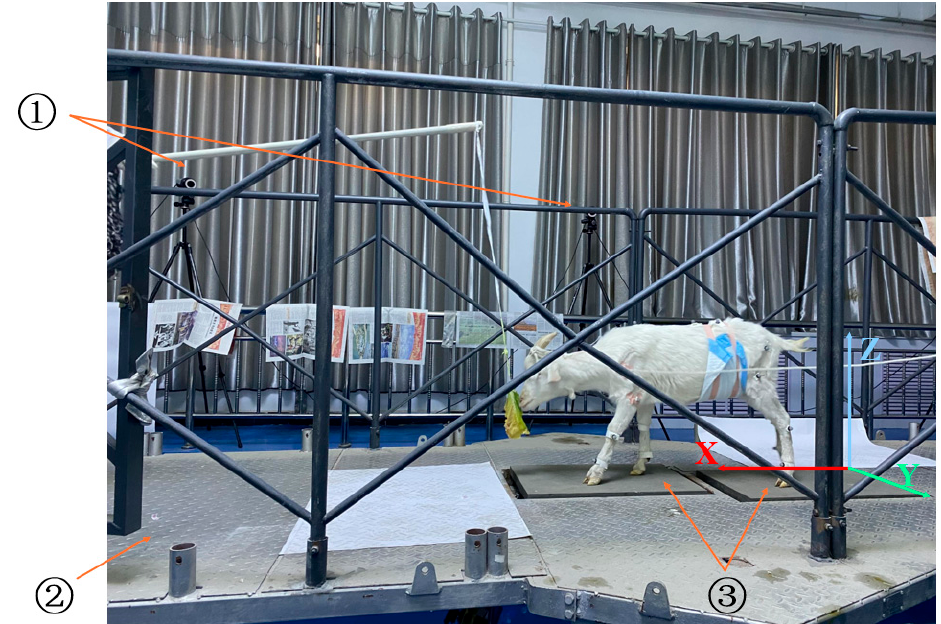
Figure 2. The motion test platform consists of ① the motion capture system, ② 6-DoF motion plat- form, and ③ the three-dimensional biomechanical force measuring table.